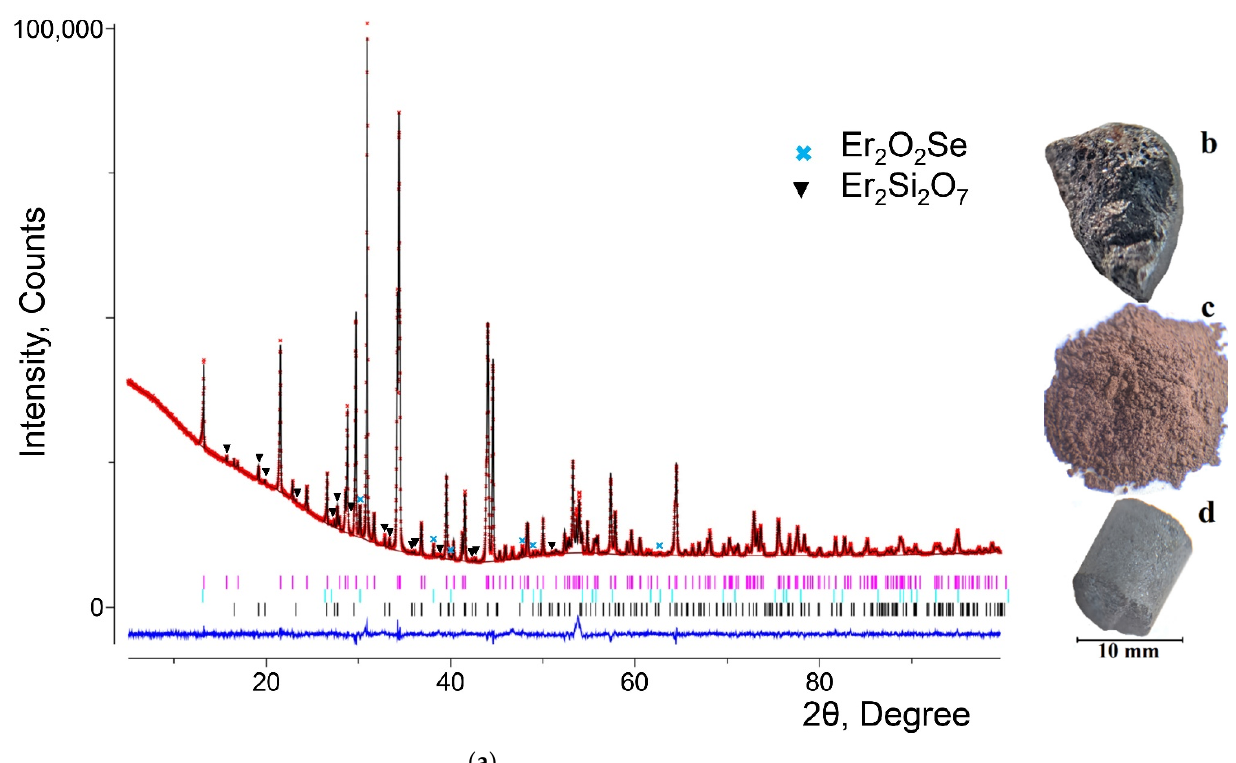
Figure 1. XRPD pattern ( a ) and photographs of EuErCuSe 3 samples, ( b )—a sample obtained by the crystallization from a melt, ( c )—powder, ( d )—technical ceramics. Magenta, blue, and black vertical marks correspond to the positions of the Bragg reflections for EuErCuSe 3 , Er 2 O 2 Se, and Er 2 Si 2 O 7 , respectively.